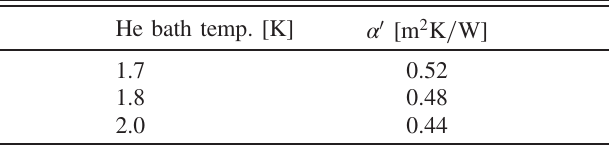
TABLE II. α 0 versus Helium bath